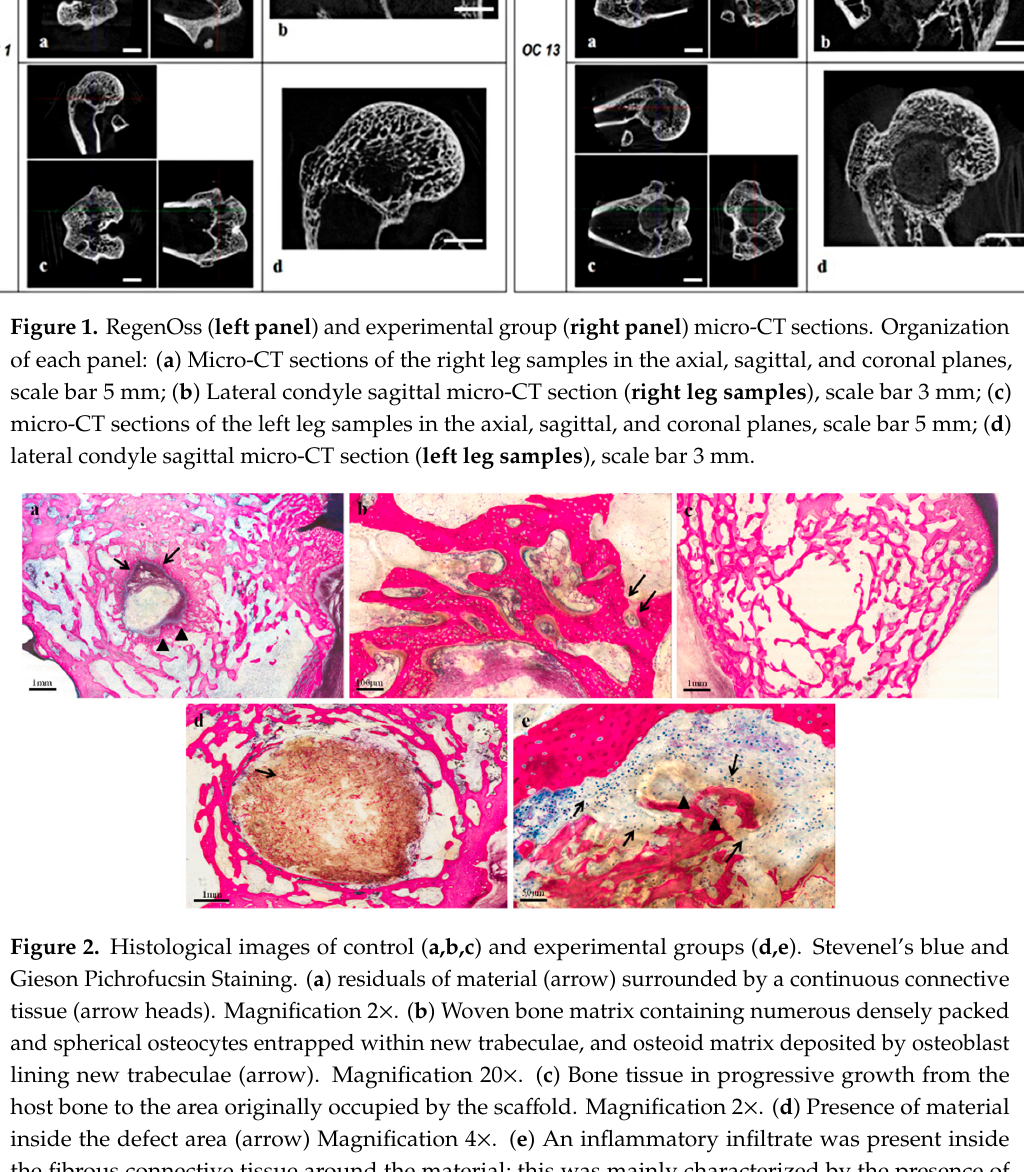
Figure 2. Histological images of control ( a,b,c ) and experimental groups ( d,e ). Stevenel’s blue and Gieson Pichrofucsin Staining. ( a ) residuals of material (arrow) surrounded by a continuous connective tissue (arrow heads). Magnification 2×. ( b ) Woven bone matrix containing numerous densely packed